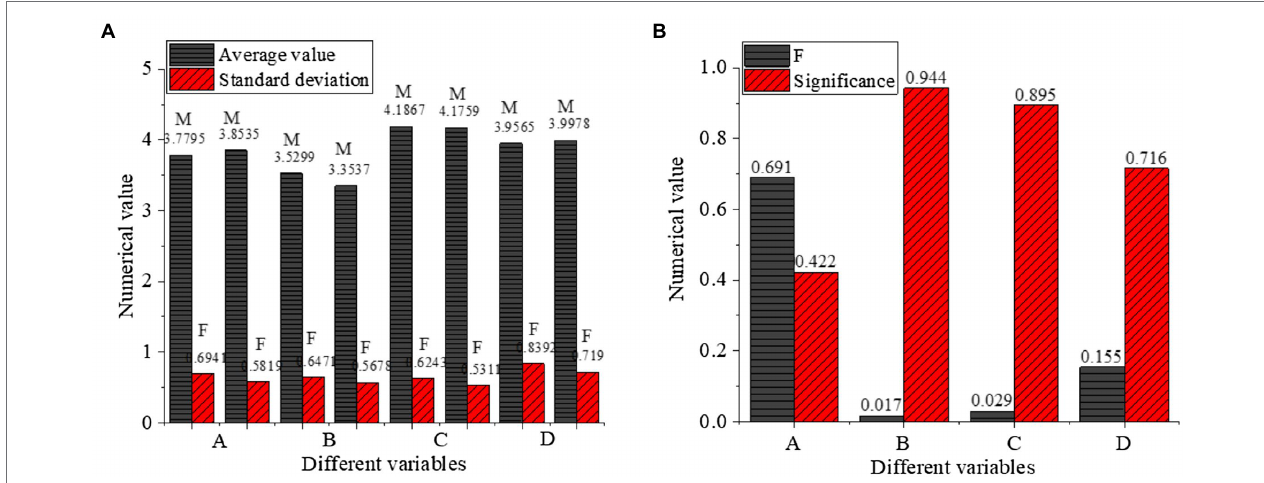
FIGURE 7 | One-way ANOVA of gender ( A : different variables with Numerical value, B : different variables with Numerical value, M: Male, F: Female, A: Cross- cultural competence, B: Cross-cultural adaptation, C: Entrepreneurial intention, D: Psychological adaptation of venture entrepreneurs).